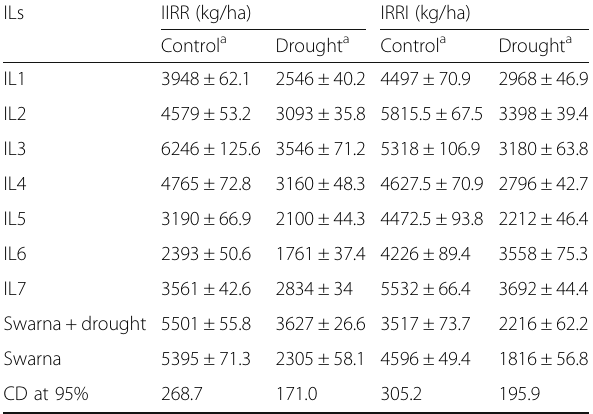
Table 5 Screening of introgression lines under reproductive stage drought stress